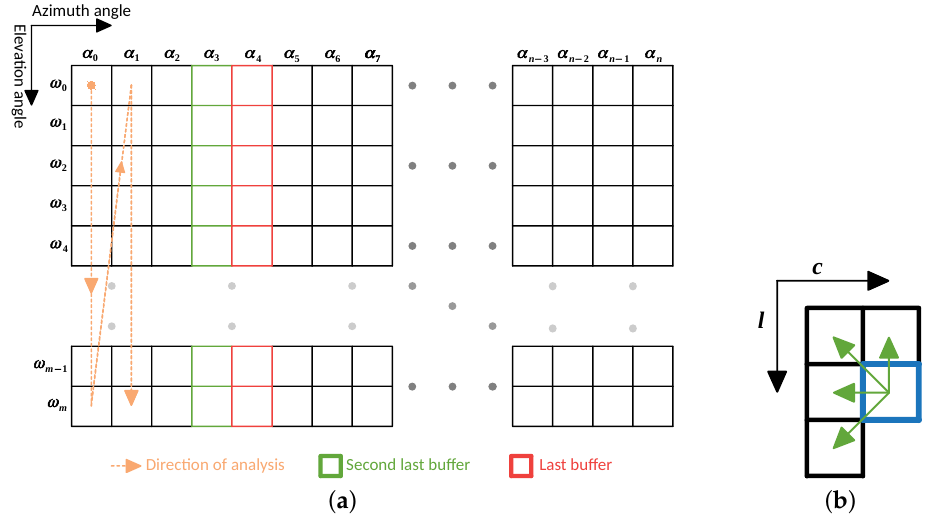
Figure 4. ( a ) LiDAR data organization; and ( b ) layout for neighbor comparison.